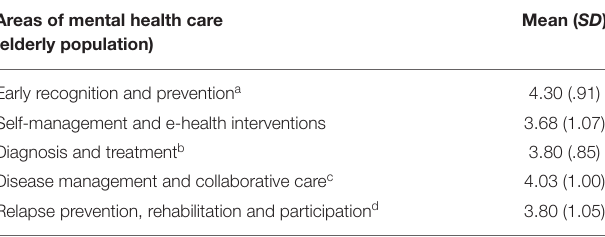
TABLE 7 | Willingness of GPs to get involved in different areas of mental health care of the elderly population. Areas of mental health care (elderly